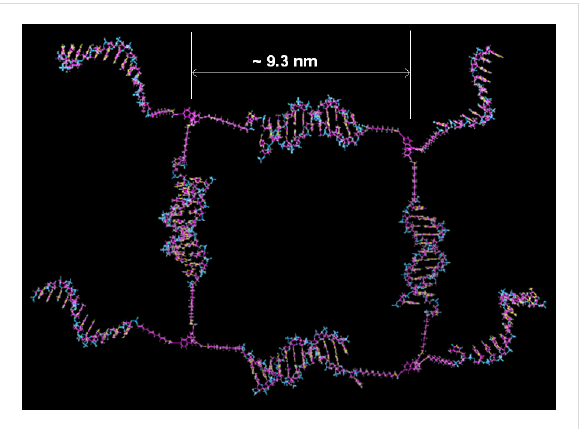
Figure 5: Modeling studies involving S1–TPA and S2–TPA triconju- gates showing a single tetrameric unit with square structure having ex- tended ssDNA arms at the corner. The vertex length of the structure was found to be ca. 9.3